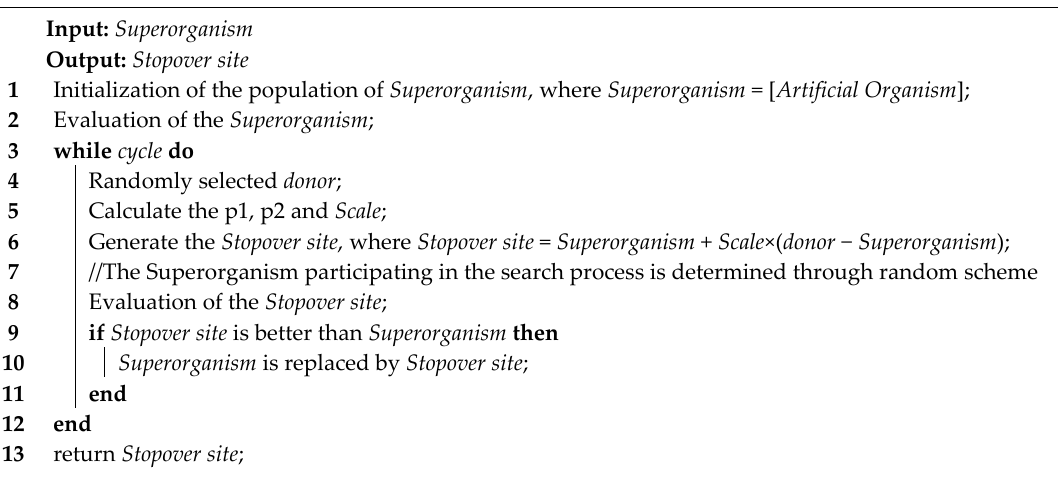
Algorithm 1. A comparison of different identifiers in terms of dynamic system